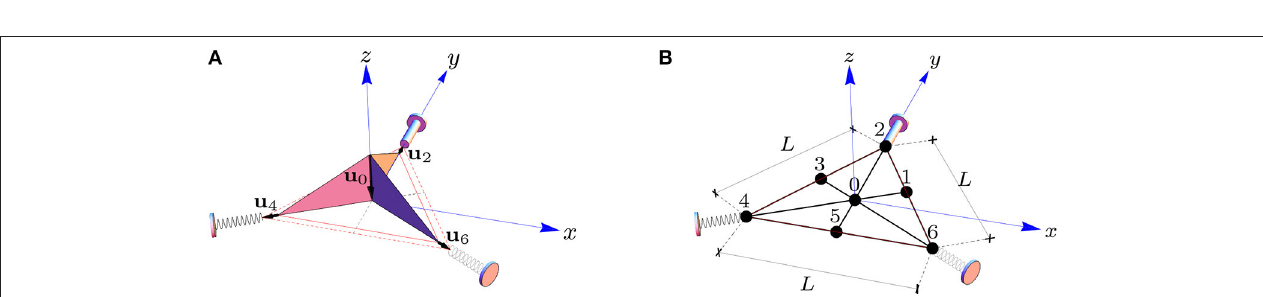
6 exhibit the same norm U of u 2 (due to symmetry), and nodes 5, 3, and 1, respectively move along the y -axis (i.e., the projected 5–2 edge onto x , y -plane, see Figure 3 ), the projected 3–6 edge (aligned with the y -axis rotated of π/ 3), and the